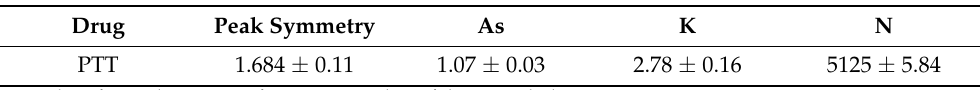
Table 3. Optimized chromatographic peak parameters for the resolution of PTT for HPLC approach (mean ± SD, n = 3). Drug Peak Symmetry